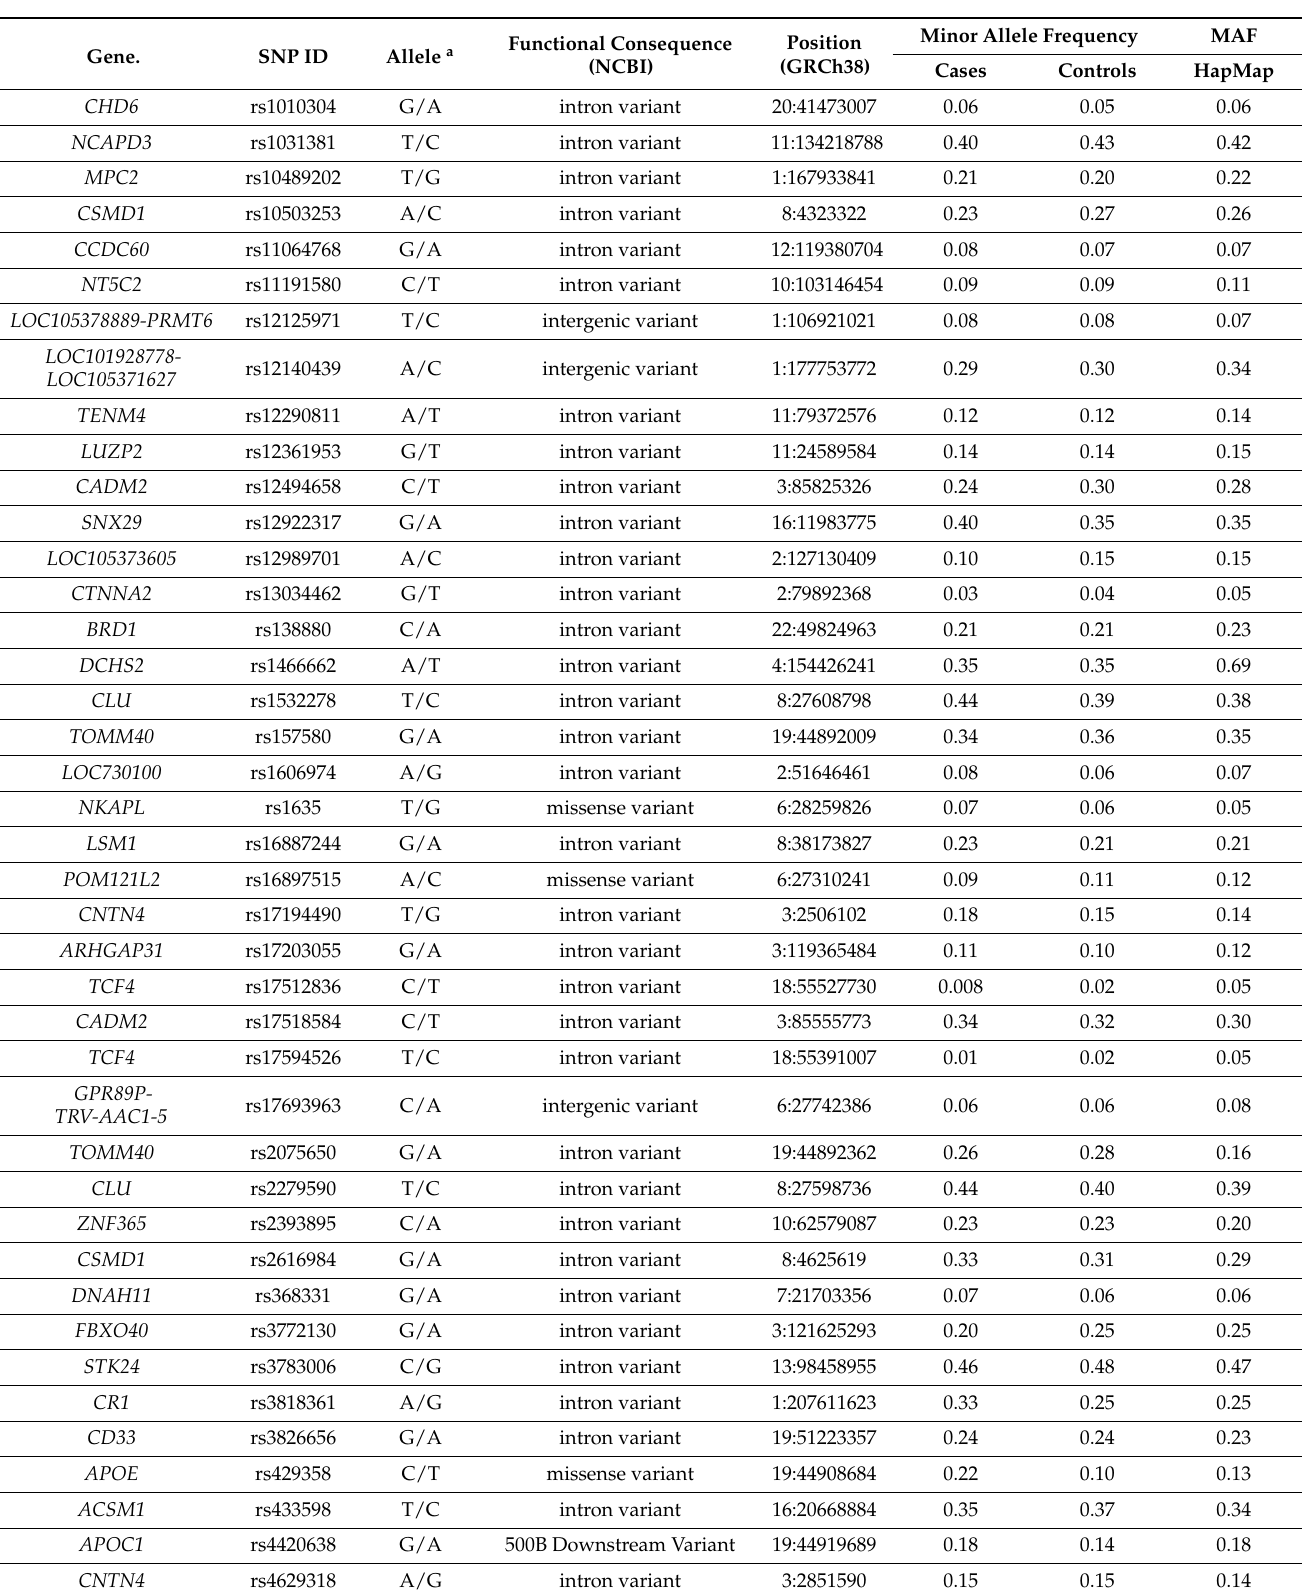
Table 2. Frequencies of the 58 SNPs analyzed for